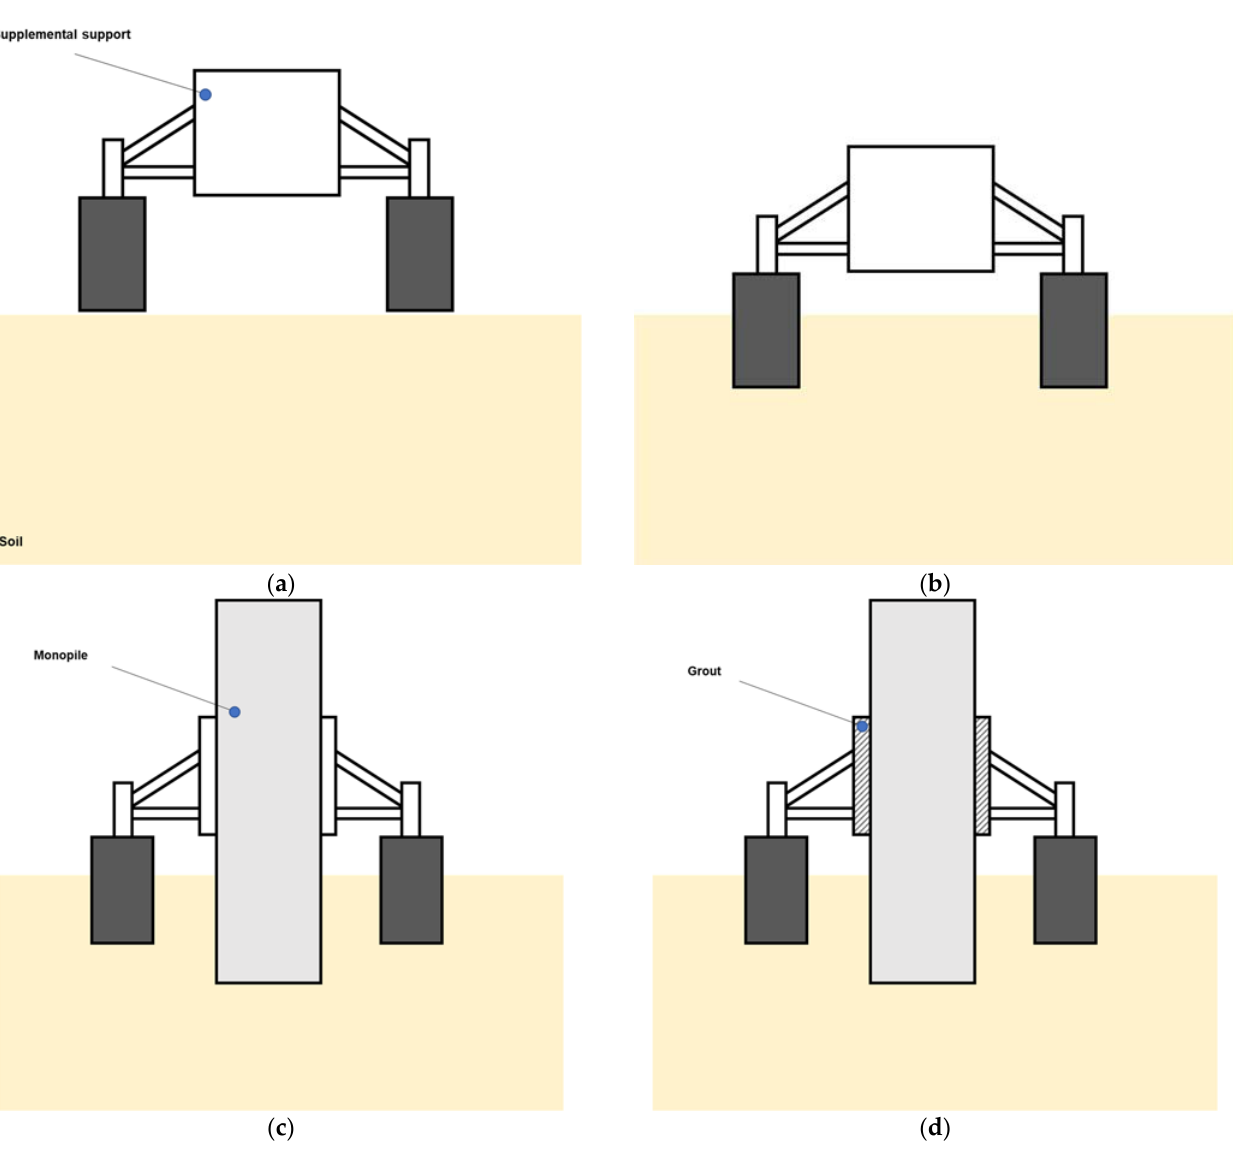
Figure 2. Hybrid monopile installation procedure ( a ) supplemental support placement; ( b ) penetra- tion by suction; ( c ) monopile installation; ( d ) grouting and penetration.